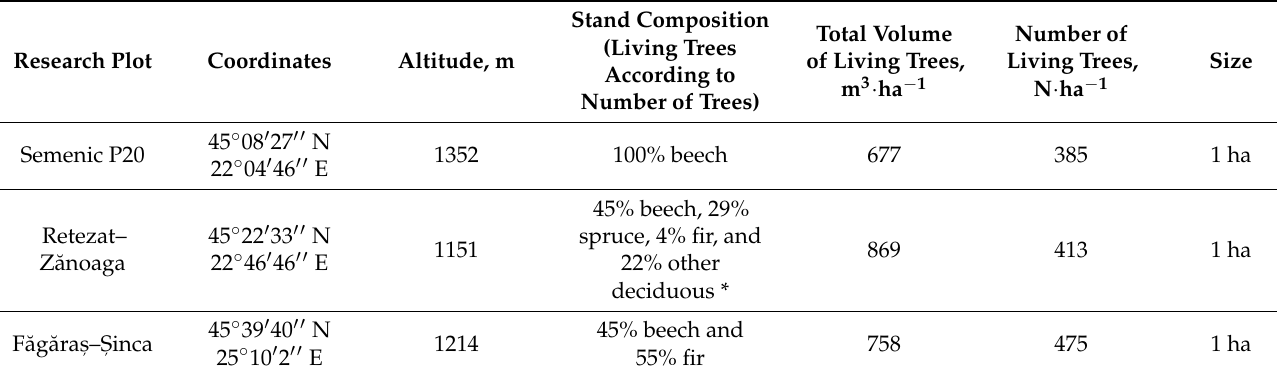
Table 1. Main characteristics of the research plots.